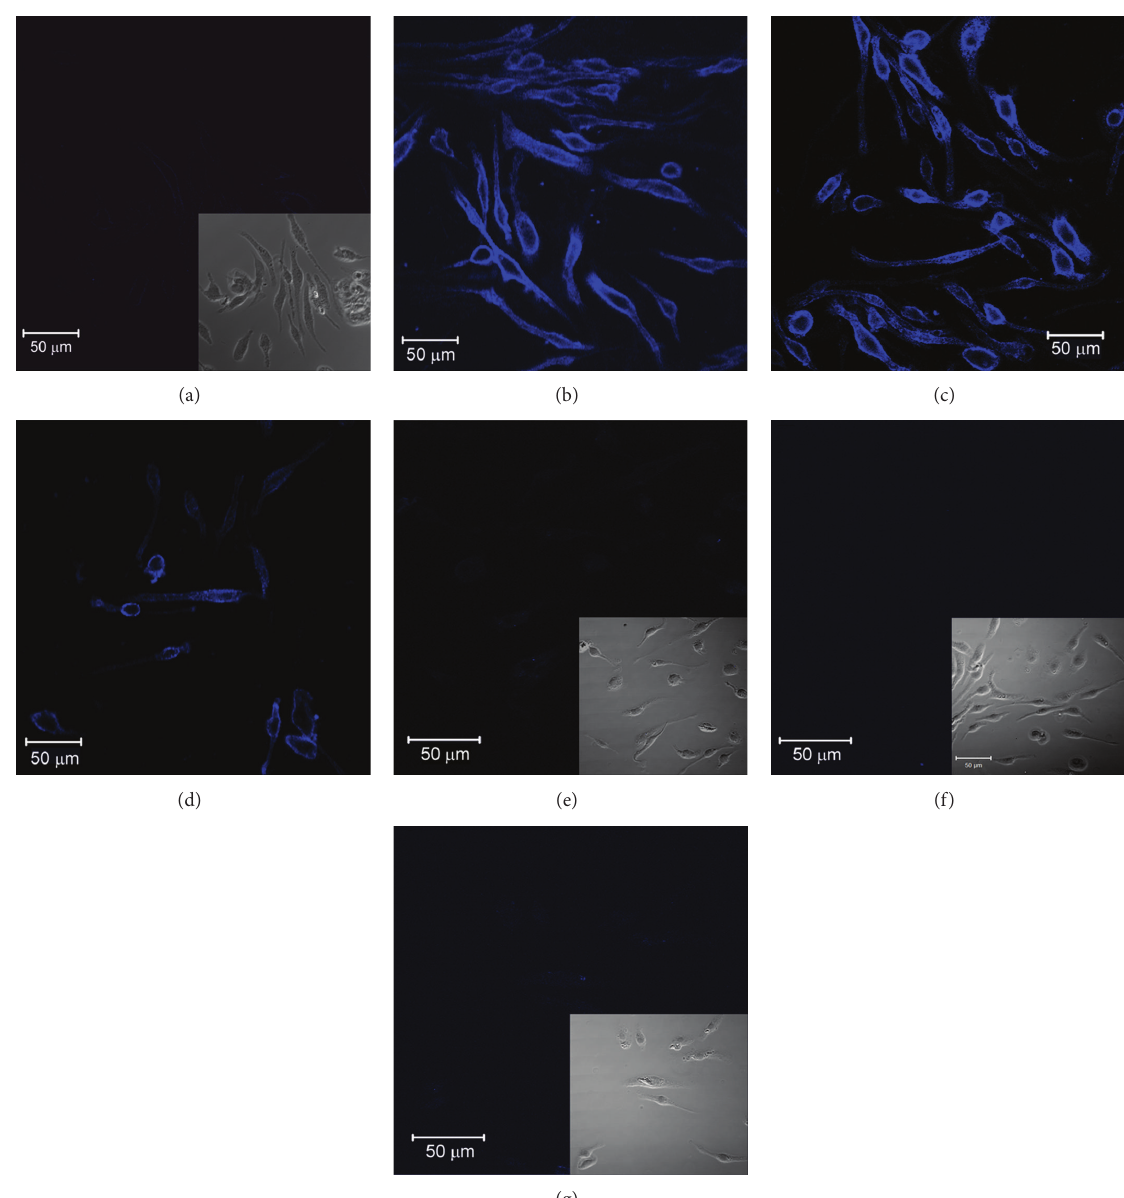
Figure 5: Immunofluorescent staining of cultured retinal microglial cells. Microglial cells were transferred into a 16-well chamber slide and stained for (a) isotype control (insert, phase contrast image to show the cells), (b) F4/80, (c) CD11b, (d) CD45, (e) MHC-II (insert, phase contrast), (f) CD86 (insert, phase contrast), and (g) CD40 (insert, phase contrast). The samples were analysed by confocal microscopy. In all imagesblueindicatesallophycocyanin(APC).Over98%ofthecellswerepositiveforCD11b,CD45,andF4/80surfacemarkersbutthestaining of CD45 was much weaker compared to CD11b and F4/80. Cells were negative for MHC-II, CD86, and CD40. Data were representative of 2